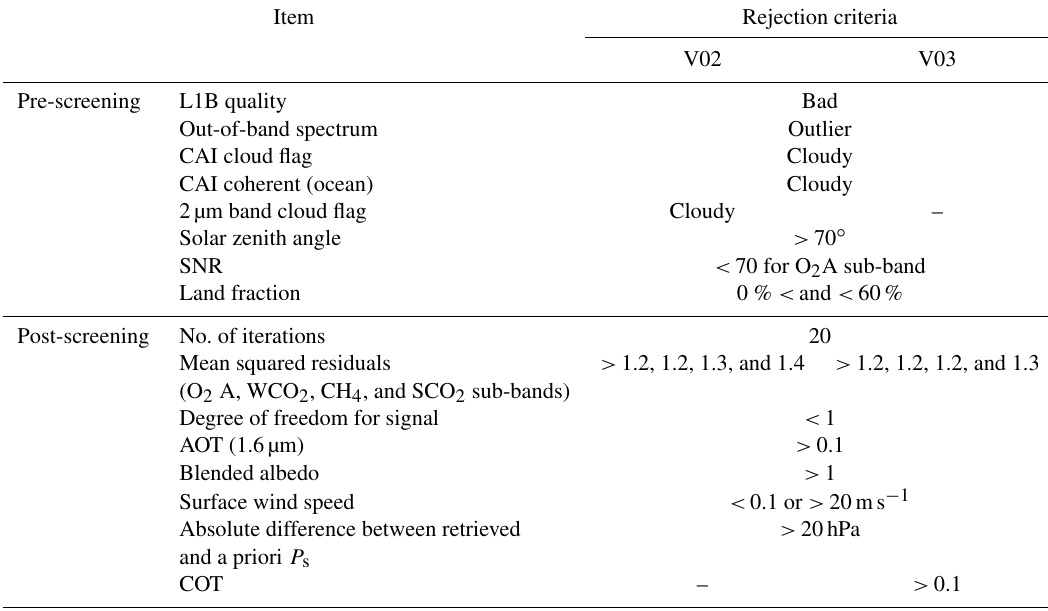
Table 3. Summary of the pre-/post-screening procedures for the V02 and V03 algorithm. The observation is rejected if more than one item satisfies the criteria.